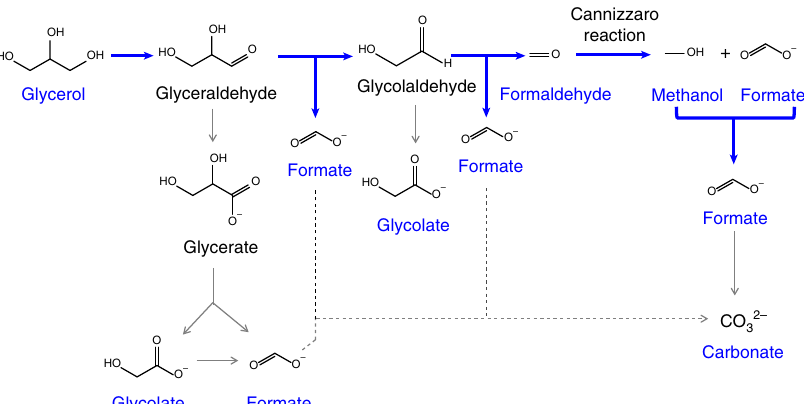
Fig. 4 Proposed mechanistic scheme of glycerol electro-catalytic oxidation to formate on Ni – Mo – N/CFC in alkaline medium (blue arrows is proposed to be the dominant